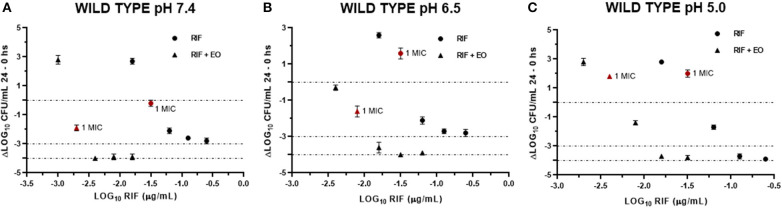
Graphic representation of the antibacterial effect (E: ΔLog CFU/ml 24–0 h) of rifaximin against Staphylococcus aureus wild type (n = 3, using the mean of triplicates for each strain) at pH 7.4 (A), 6.5 (B), and 5.0 (C) in the presence and absence of EO.